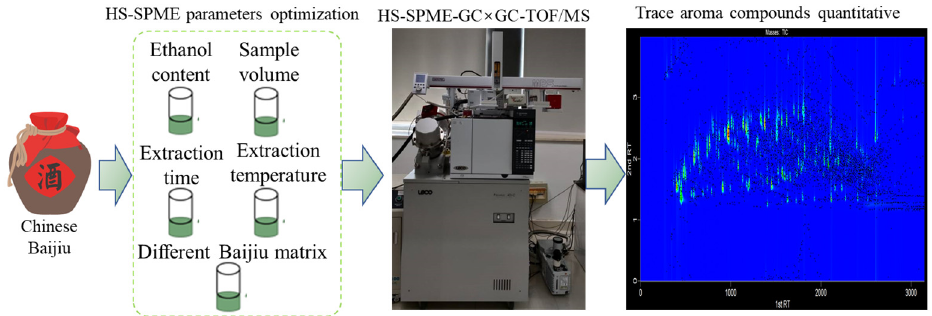
Figure 1. Schematic diagram of the determination of volatile compounds via HS-SPME-GC×GC- TOFMS.